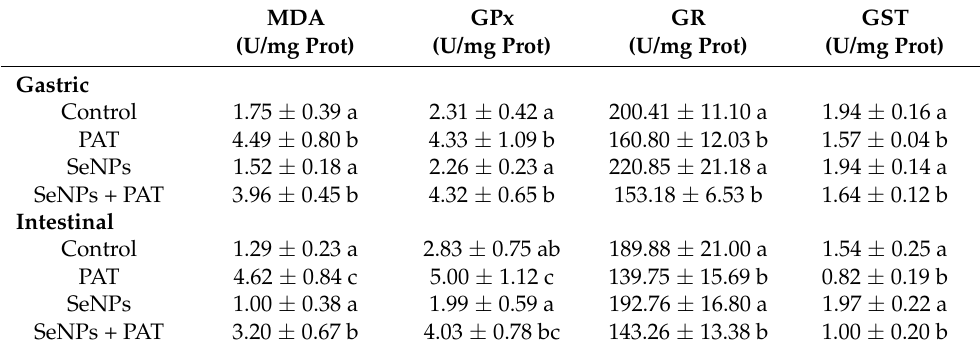
Table 4. Effect of SeNPs on MDA and PC levels and the activities of SOD and GPx in gastric and intestinal of PAT-treated mice *. MDA (U/mg